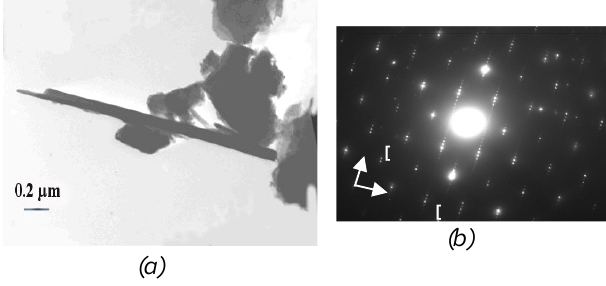
Figure 4: (a) Transmission electron image of antigorite fibrils as seen perpendicularly to fibre axis, i.e. [001] crystallographic direction. (b) Selected area electron diffraction from a sample shown in (a) taken along the same crystallographic